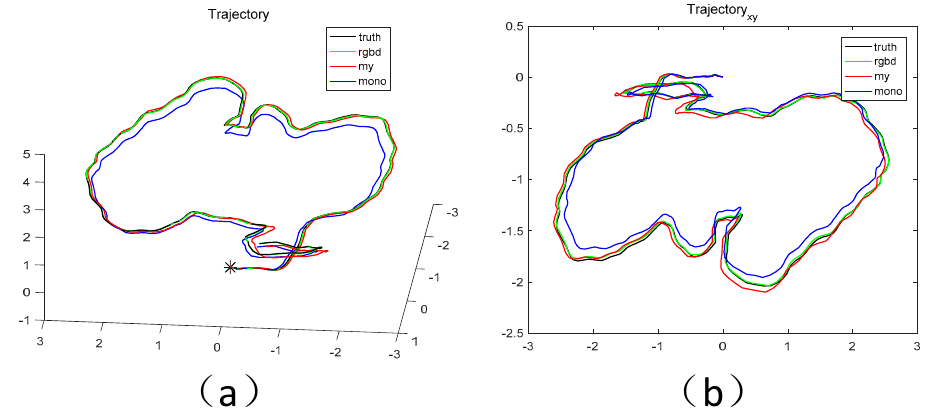
Figure 5. The 3D display of trajectory. ( a ) fr3/office, ( b ) fr3/near.